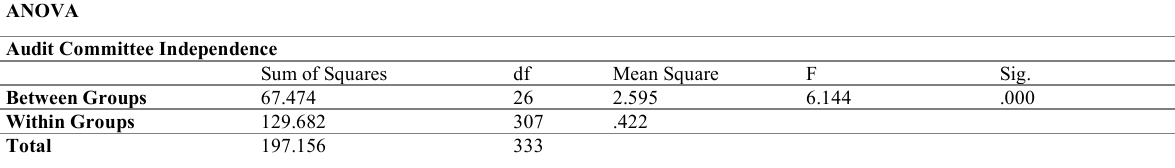
Table 8: One-Way ANOVA for AUDIND and Firm